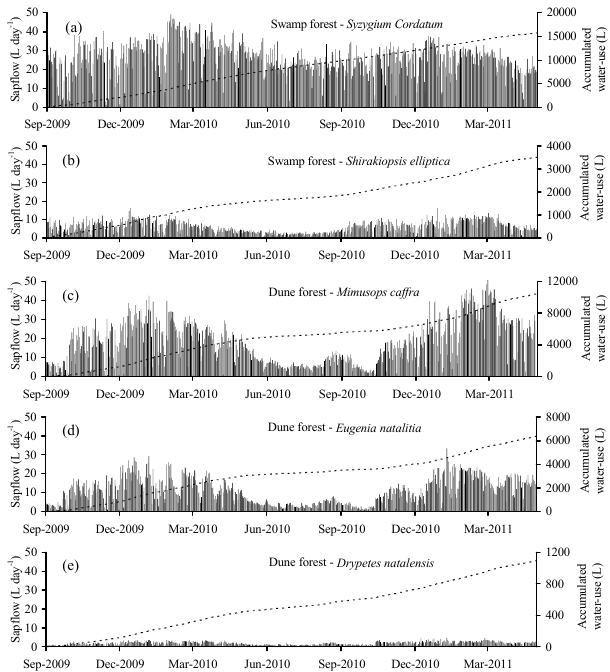
Fig. 8. Daily water use (bars) and accumulated water use (dashed line) over 20 months of the peat swamp forest trees (a) Syzygium cordatum (b) Shirakiopsis elliptica and dune forest trees (c) Mimu- sops caffra , (d) Eugenia natalitia and (e) Drypetes natalensis .